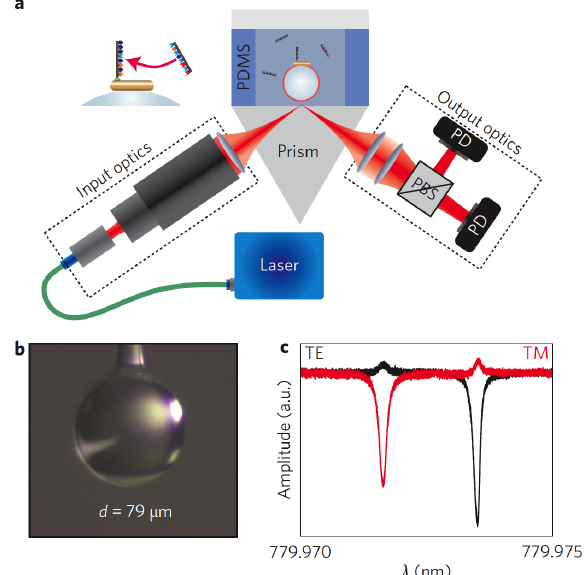
Figure 12. Experimental setup of the WGM plasmon-enhanced biosensing platform. ( a ) A prism coupler is used to excite WGMs in a glass microsphere. The liquid sample cell is made in PDMS. The inset shows a plasmonic nanorod enabling detection of single oligonucleotides. ( b ) Photo of the spherical WGMR, with a diameter in the range of 60–100 µ m. ( c ) Example spectra for TE(black) and TM(red) polarization obtained with an ≈ 79 µ m microsphere in water, exhibiting typical experimental Q values around 5 × 10 6 . Reprinted with permission from